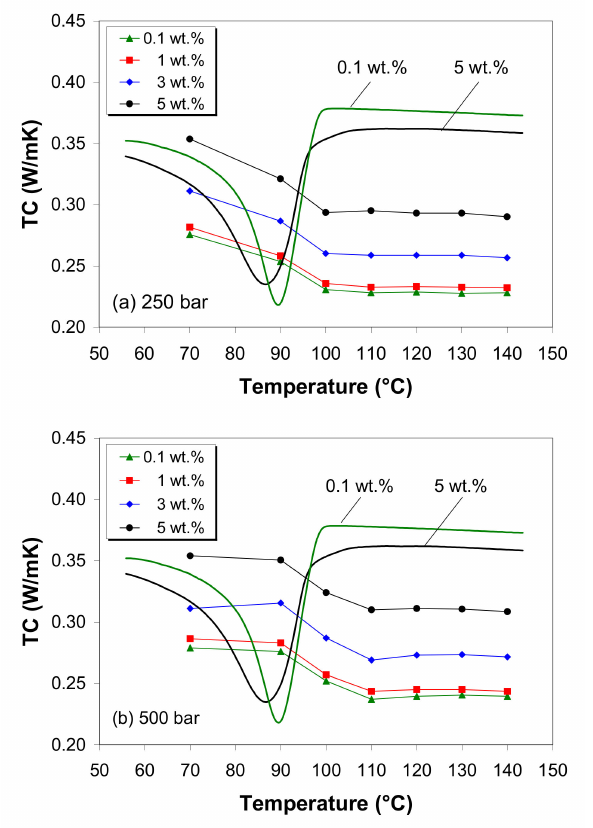
Figure 13. Thermal conductivity of the LDPE / MWCNT composites as a function of temperature and MWCNT wt.% at ( a ) 250 bar and ( b ) 500